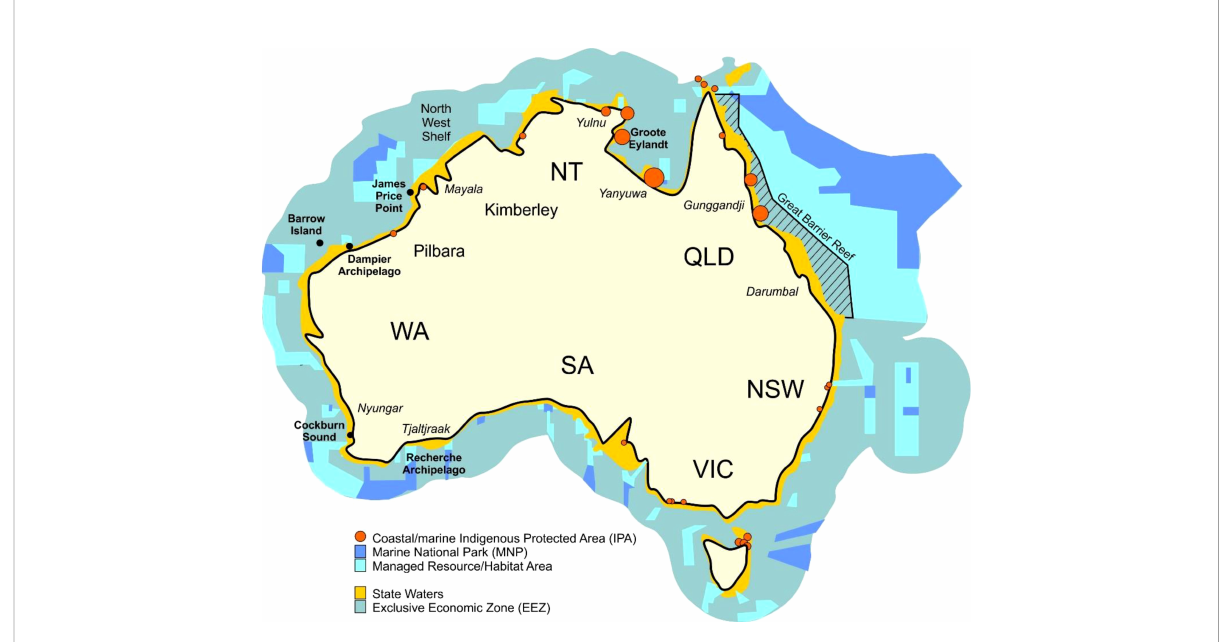
FIGURE 1 Overview of Australian protected areas and Indigenous Protected Areas (IPA) (modi fi ed from Collaborative Australian Protected Area Database, Australian Government Department of the Environment and Energy, 2014). Australian state and territories (capitalized), regions (large text), names of Indigenous groups (italics), locations (bold) mentioned in text are also included. For a more comprehensive map and list of current and proposed IPAs, see Gould et al. (2021), their Figure